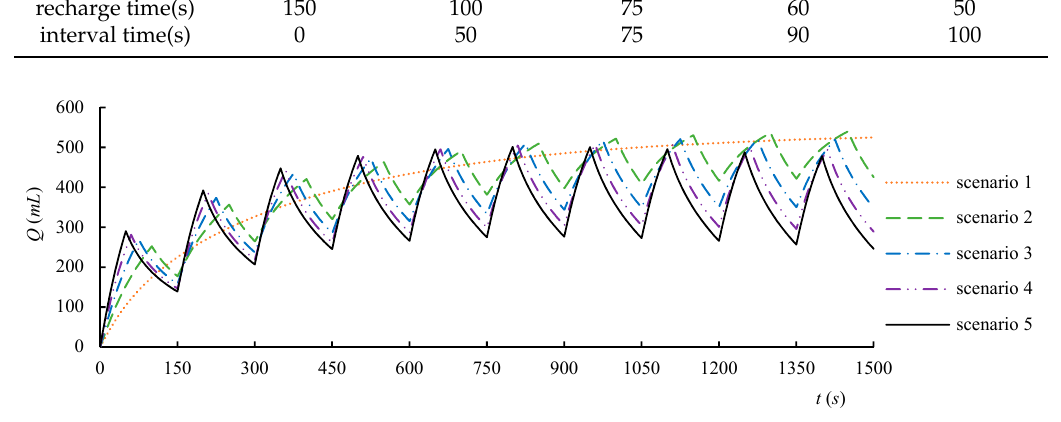
Figure 16. Curves of ESC ( Q ) change with time for different scenarios.